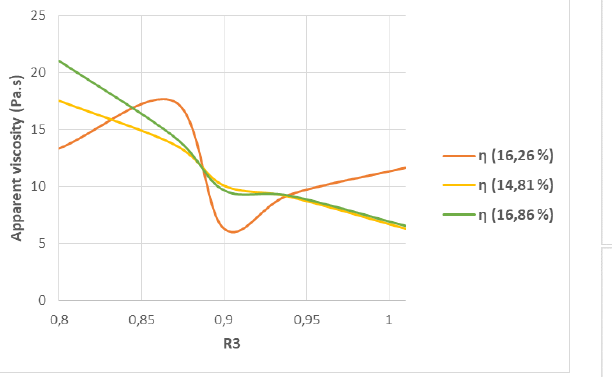
Figure 9: Effect of L/S on the apparent viscosity